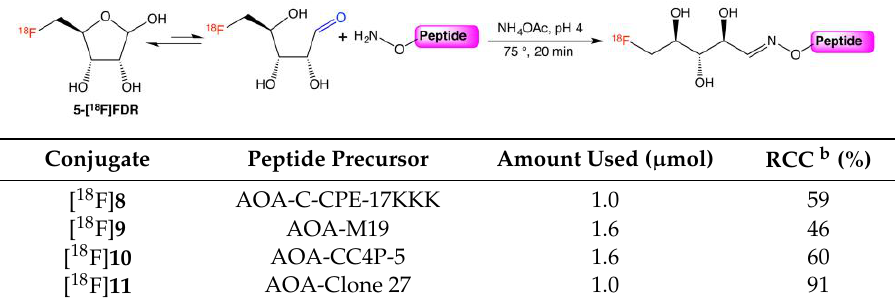
Table 2. Conjugation of 5-[ 18 F]FDR with aminooxy-functionalized peptides a .